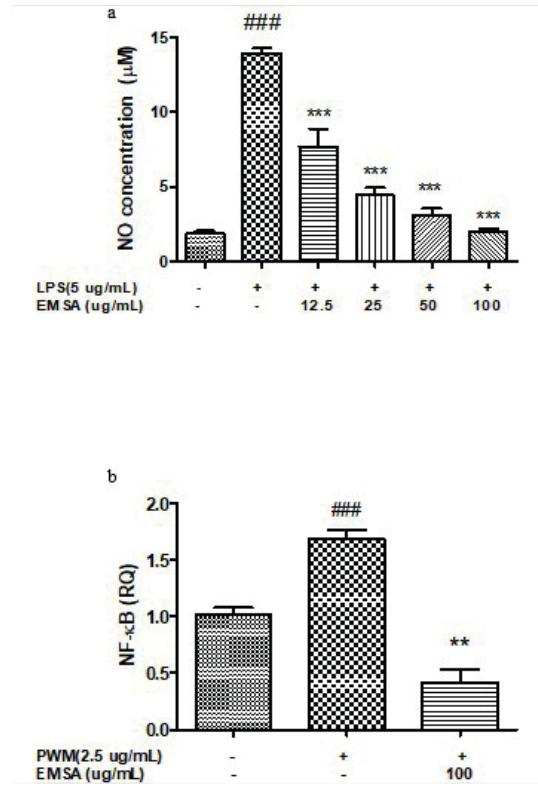
Figure 5 - ( a ) Effect of EMSA in NO production in LPS- stimulated macrophages. n = 6 (p ### <0.001 vs Control; *** p<0.001 vs. LPS). ANOVA and Tukey’s tests. ( b ) Effect of eMSA on the expression of NF-kB in culture stimulated with PWM. n = 6, (### p<0.001 vs. Control; ** p<0.01 vs. PWM) ANOVA, Tukey. ### p<0.001 vs. Control; ***p<0.001 vs. PWM). ANOVA and Tukey’s tests.